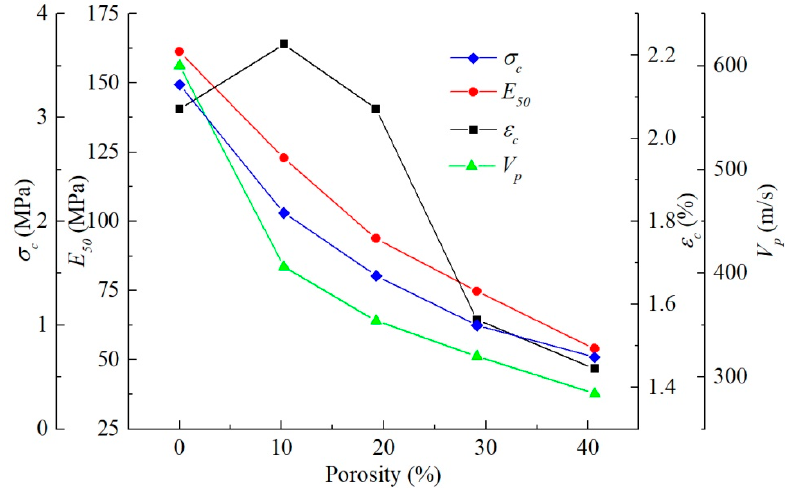
Figure 18. Relationship between porosity and macroscopic static and dynamic parameters.